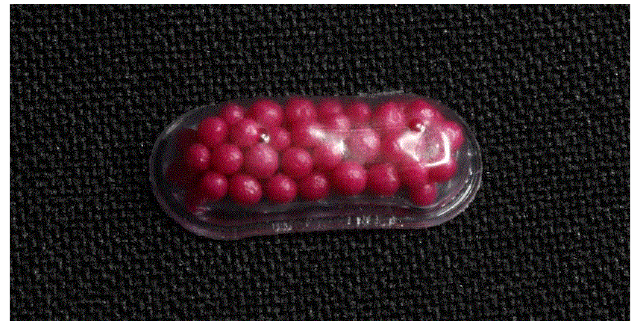
Fig.1. Rectangular capsule containing an acid fuchsin pigment.